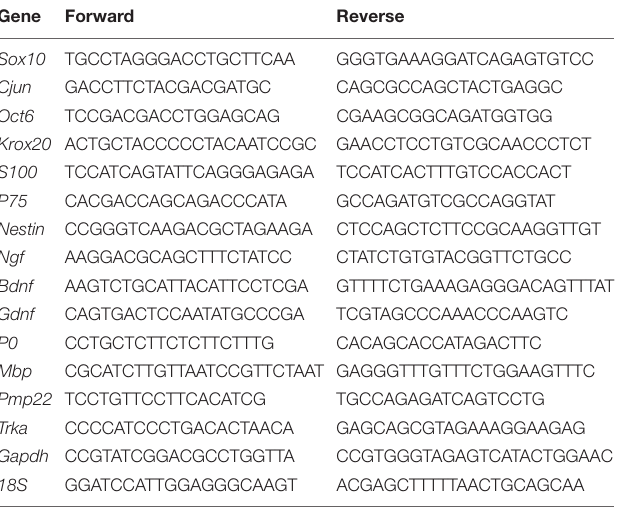
TABLE 1 | Primer sequences used in PCR studies.